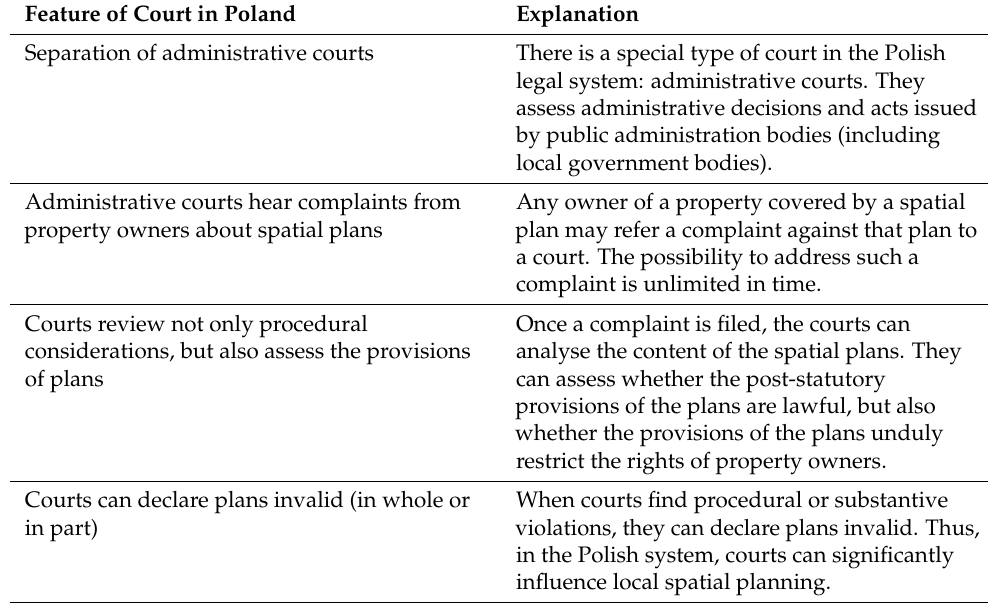
Table 1. Characteristics of Polish courts in spatial planning